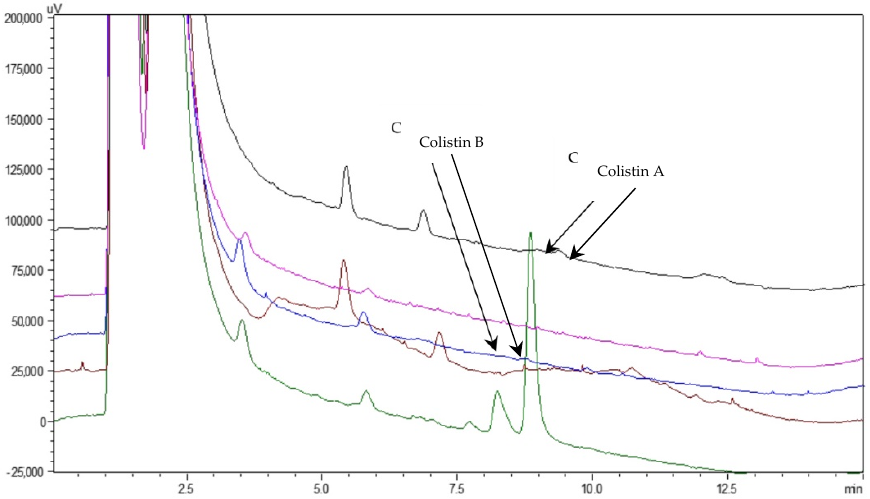
Figure 4. Representative HPLC–PCD chromatograms of the analysis of drug ‐ free urine samples (brown, blue, fuchsia, and black line) and spiked with Colistin at the concentration level of 1750 nmol ∙ L − 1 (green line).